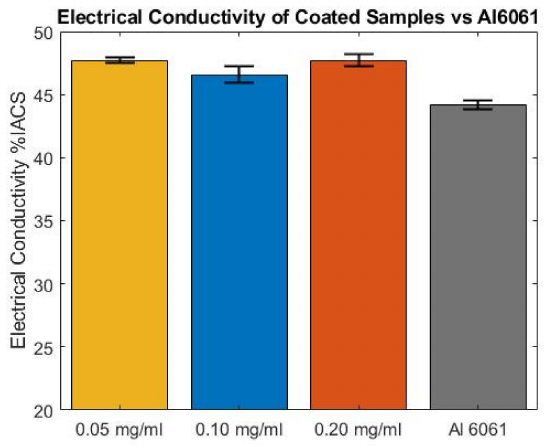
Figure 5. %IACS as a function of the MWCNTs’ concentration solutions. The electrical conductivity is enhanced by 9.6%, 7% and 9.6%, respectively, for MWCNTs concentrations of 0.05, 0.10 and 0.20 mg /